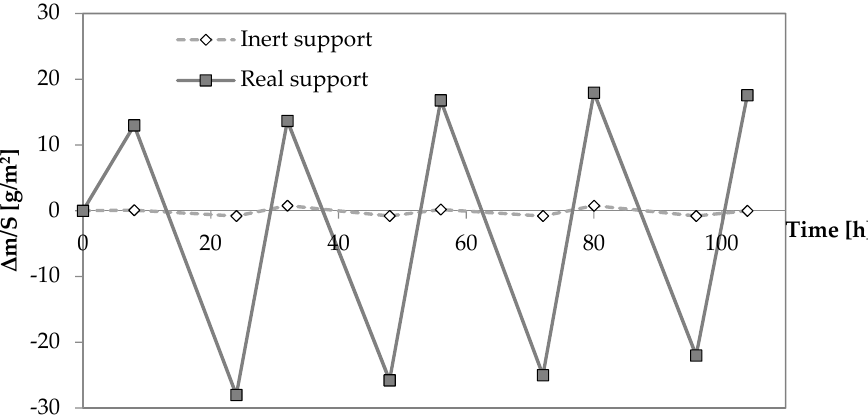
Figure 5. Moisture buffering value ( MBV ) of paints applied on the real support or inert support. Blank is the support (real or inert) without coating.